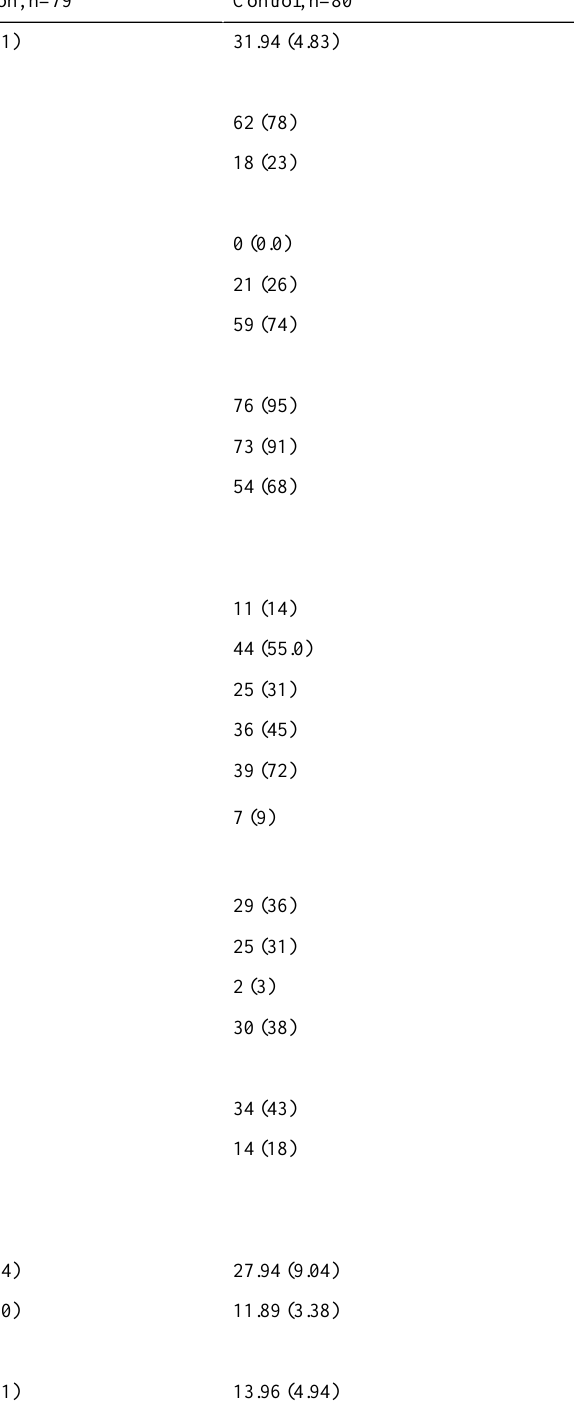
Control, n=80Intervention, n=79Demographic